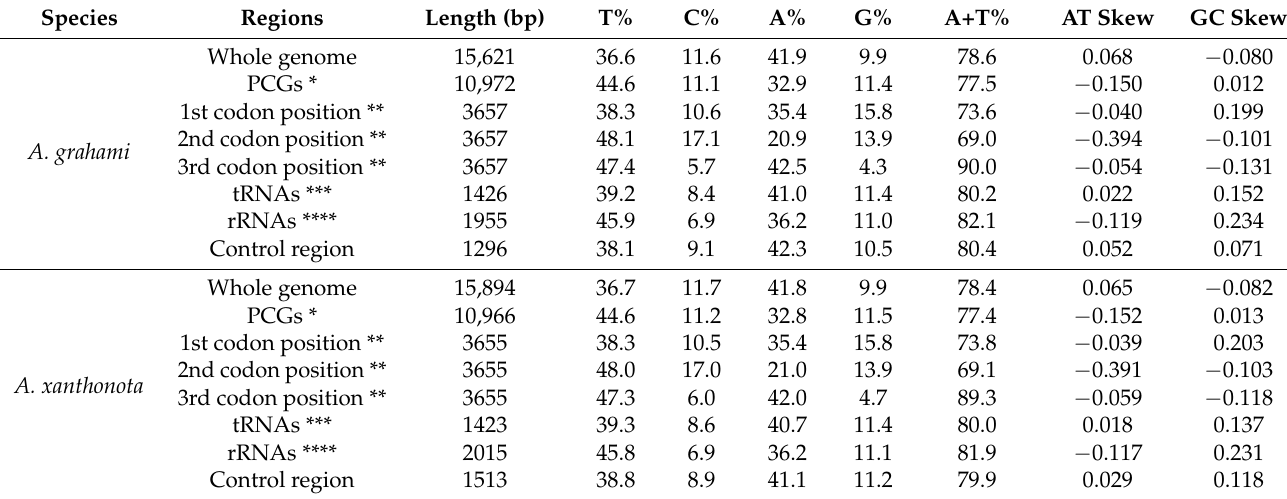
Table 4. Nucleotide composition of the Atkinsoniella grahami and Atkinsoniella xanthonota